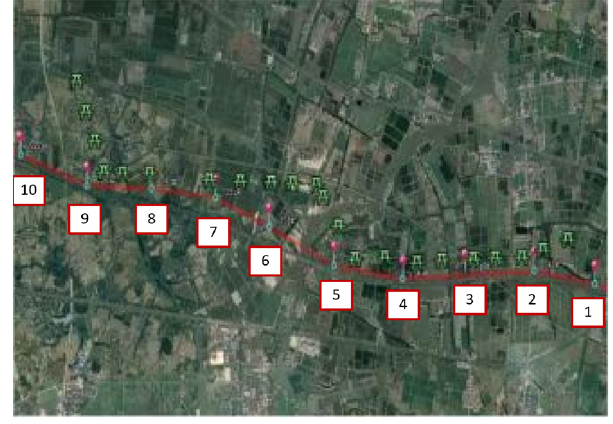
Figure 5. Distribution of power transmission lines and long-distance pipelines. The test stakes are numbered 1 to 10 in sequence from right to left. A peak AC-induced voltage of 44.47 V was present on the first pipe at test pile 3, and a peak AC-induced voltage of 16.65 V was present on the second pipe under test pile 6; a low value of 6.49 V was measured on the first AC induced voltage at test pile 5, and a low value of 5.35 V was measured on the second pipe AC induced voltage at test pile 7. The simulated results were compared with the measured voltages in the field, and the results showed that the two predicted peak AC induction voltages were 44.89 V and 19.02 V, respectively, which differed from the measured data in the field by 0.42 V and 2.37 V. The two simulated low AC induction voltages were 4.81 V and 3.31 V, which differed from the measured data in the field by 1.68 V and 2.04 V. The error was within the permissible range, and the simulation could be used to continue the study. The model can be used to continue the